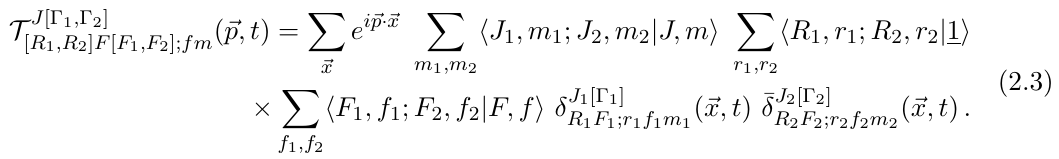
Table 1 . Subduction of continuum spin J into lattice irreps (cid:3) of O h for J (cid:20) 4. tetraquark operator, projected onto momentum ~p ,